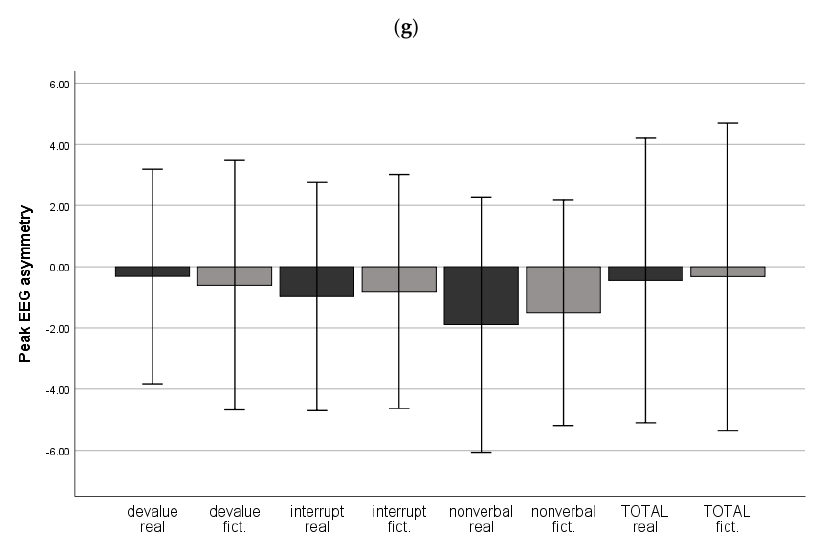
Figure 3. Physiological responses during real-life (real) and fictional (fict.) social rejections. Values represent the change scores (baseline subtracted). ( a ) Heart rate (HR), ( b ) mean EDA, ( c ) skin conductance response (SCR), ( d ) zygomaticus major , ( e ) corrugator supercilii , ( f ) mean EEG asymmetry, and ( g ) peak EEG asymmetry. Error bars: +/ − 1 SE (* p < 0.05, ** p ≤ 0.001, FDR < 0.1).